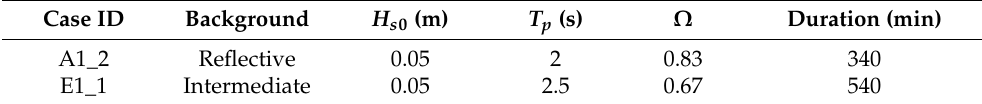
Table 1. Incident wave